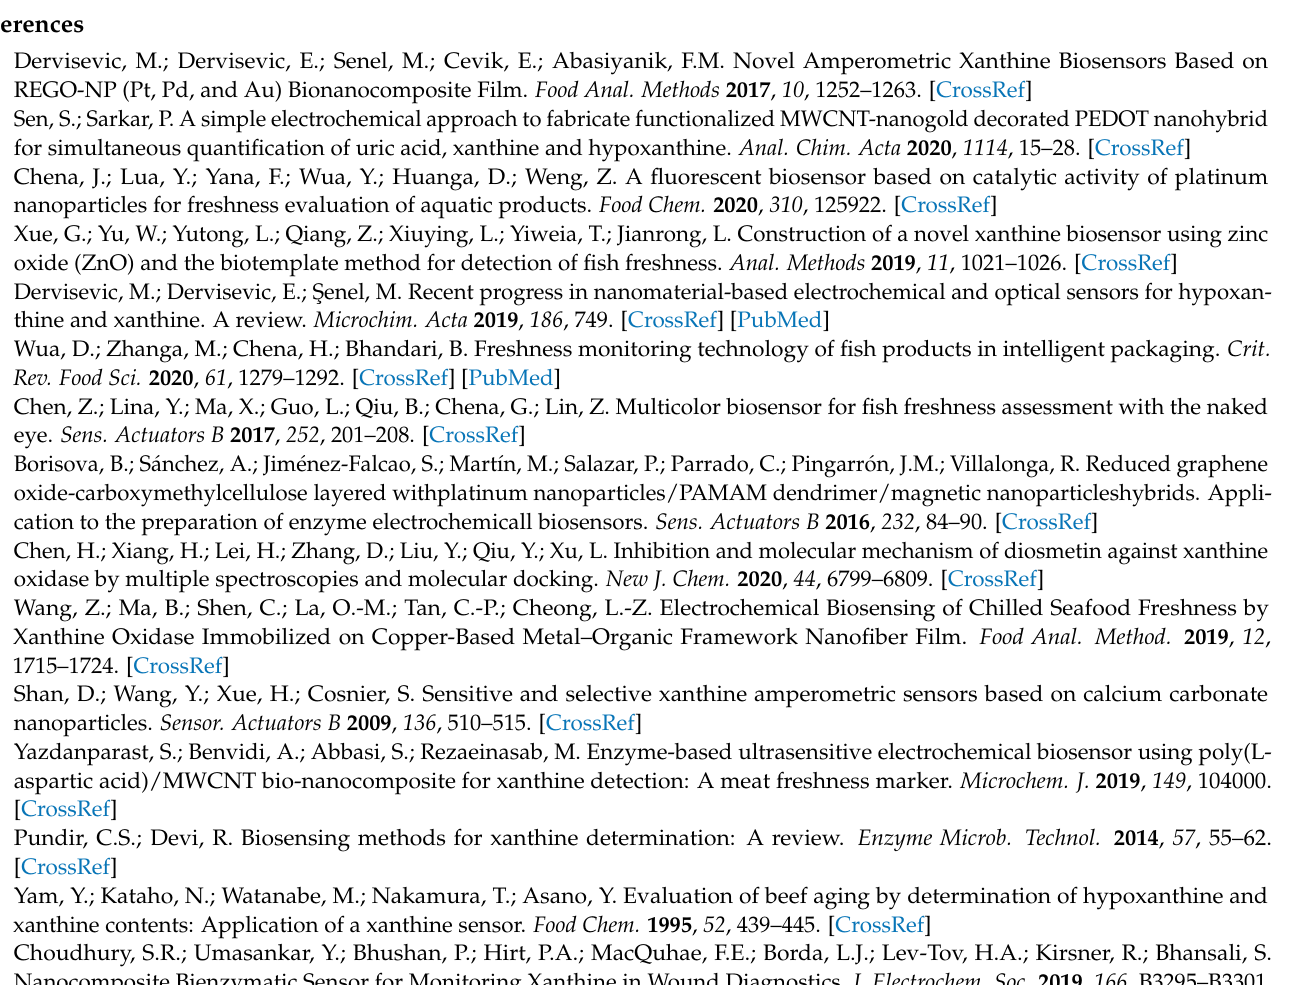
Nyquist plot, fit and simulation, equivalent circuit and impedance data of Pt bare, Figure S5: Nyquist plot, fit and simulation, equivalent circuit and impedance data of a FPP modified electrode, Figure S6: Nyquist plot, fit and simulation, equivalent circuit and impedance data of a PtNPs/FPP modified